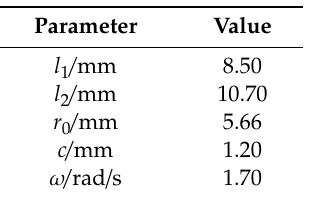
Table 2. Design parameters of mechanism.